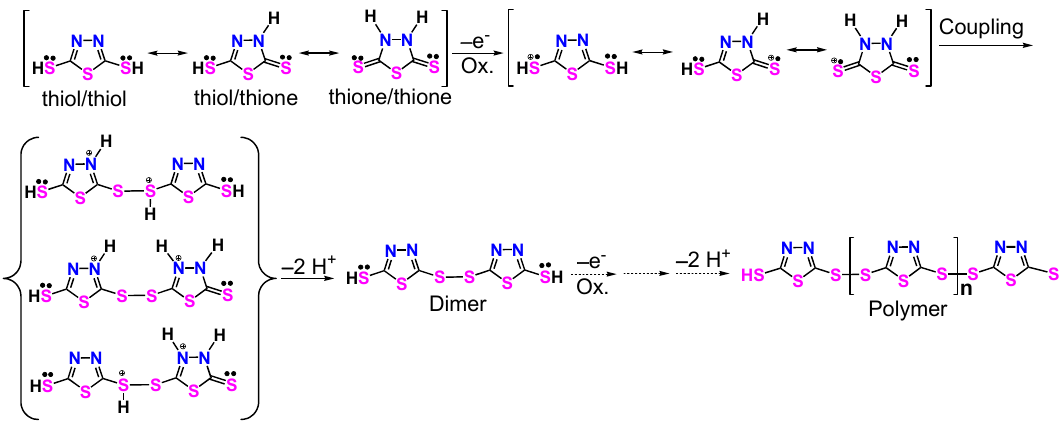
Scheme 2. Proposed polymerization mechanism of BT.